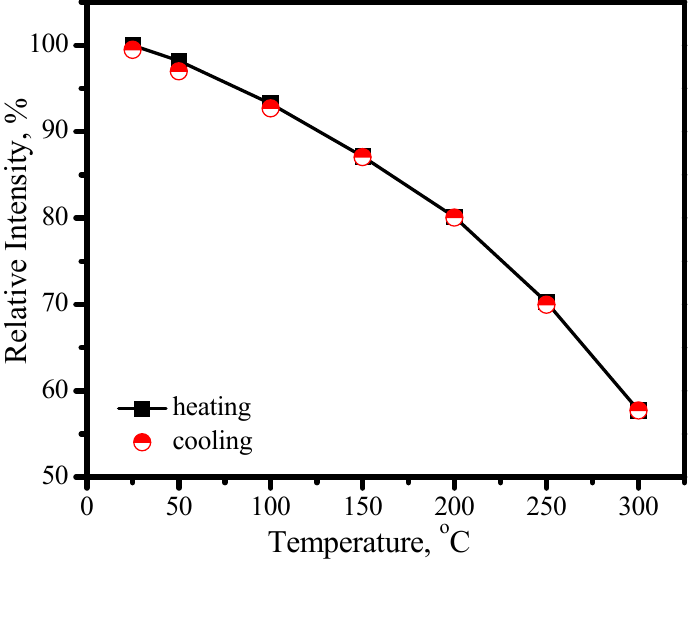
Figure 28. Luminescence intensity of (Sr excitation as a function of